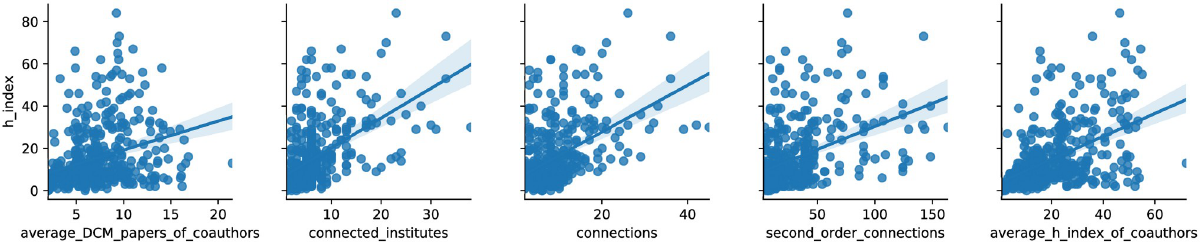
Fig 3. Distributions of various network metrics with H-Index. Average DCM papers of co-authors is the total number of papers an author’s co- authors have published. Connected institutes is the number of distinct research institutes in which the author had co-authors. Connections are the total number of an author’s co-authors. Second order connections are the total number of the co-authors’